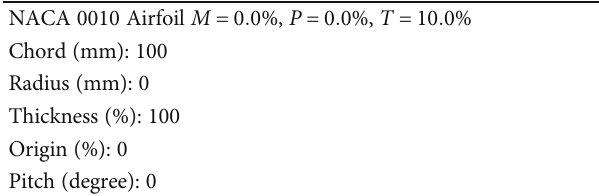
Figure 5: Comparison of numerical and experimental results [3] for thrust and torque coe ffi cients. Table 6: Information of decelerating duct